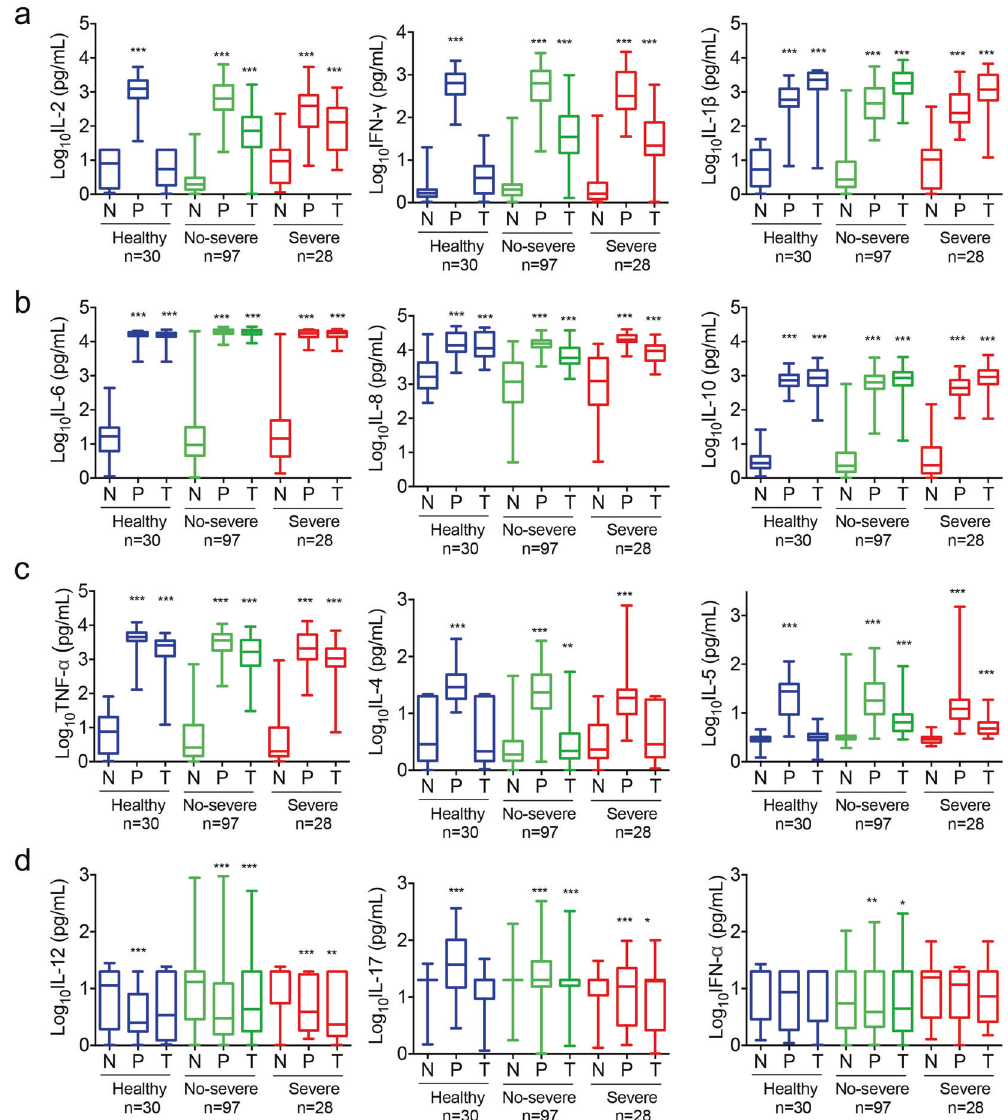
Fig. 4 Cytokine responses to SARS-CoV-2 in COVID-19 convalescent individuals. Whole blood from COVID-19 convalescent individuals and healthy donors was treated with recombinant antigen peptide pools (NP, S1, S2, and S-RBD) and PHA control overnight, followed by cytokine analysis. ( a – d ) Responses of 12 kinds of cytokines were described by a histogram. N, negative control, without treatment. P, PHA treatment. T, antigen peptide pools (NP, S1, S2, and S-RBD) treatment. Severe, individuals in the convalescent phase after severe